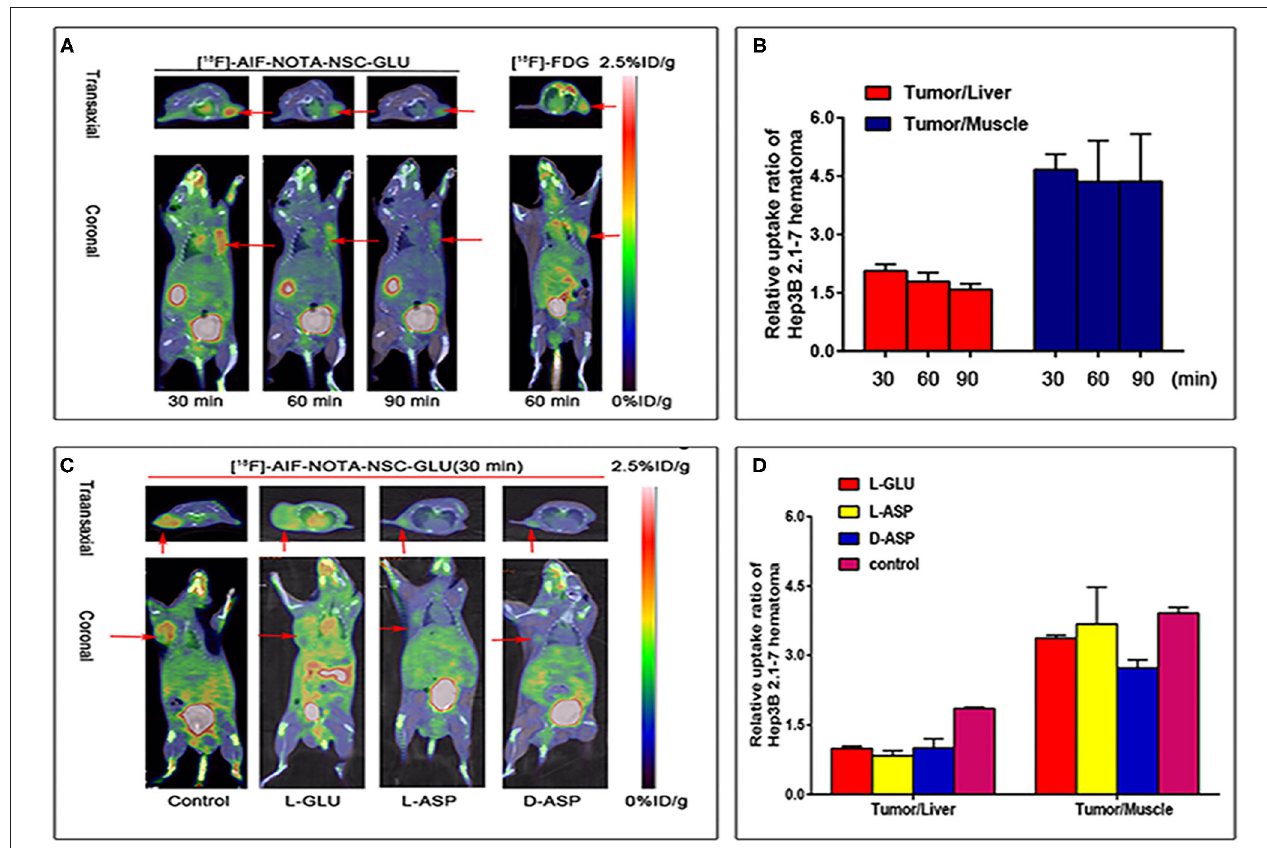
FIGURE 5 | Small animal PET imaging of tumor-bearing (HCC Hep3B cell lines) nude mice. (A) PET/CT fusion images of tumor-bearing mouse static scans at 30, 60, and 90min after the injection of [ 18 F]AlF-NOTA-NSC-GLU, and images of the same tumor-bearing mouse after 60min post-injection of [ 18 F]FDG. (B) T / L and T / M ratios in tumor-bearing nude mice at different time points post-injection of [ 18 F]AlF-NOTA-NSC-GLU. (C) PET/CT fusion images of tumor-bearing mouse static scans at 30min after the injection of [ 18 F]AlF-NOTA-NSC-GLU in vivo competitive binding. (D) The T / L and T / M ratios at 30min post-injection of [ 18 F]AlF-NOTA-NSC-GLU after the injection of L-glutamate (L-Glu), L-aspirate (L-Asp), and D-aspirate (D-Asp), respectively. PET/CT, positron emission tomography/computed